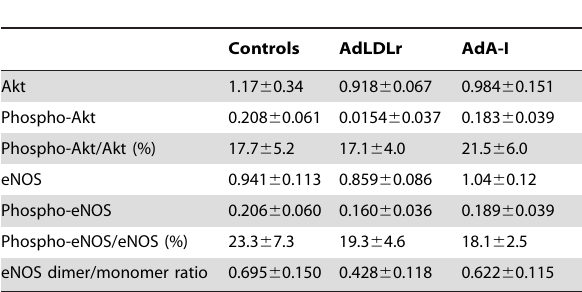
Table 5. Protein expression in the left ventricular myocardium evaluated by quantitative Western blot 6 weeks after gene transfer or saline